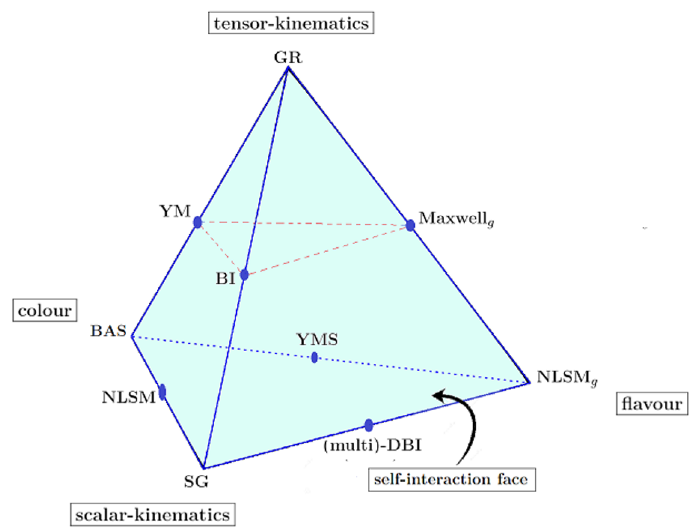
Figure 4. The tetrahedron spanned by the four different BCJ numerators that theories can factorise into. Taking all possible products results in the indicated web of dualities (including colour- (tensor-)kinematic and flavour-(scalar-)kinematic) between the different spin-2, -1, and -0 effective field theories. The right face of the tetrahedron corresponds to EFTs that retain interactions when restricted to a single